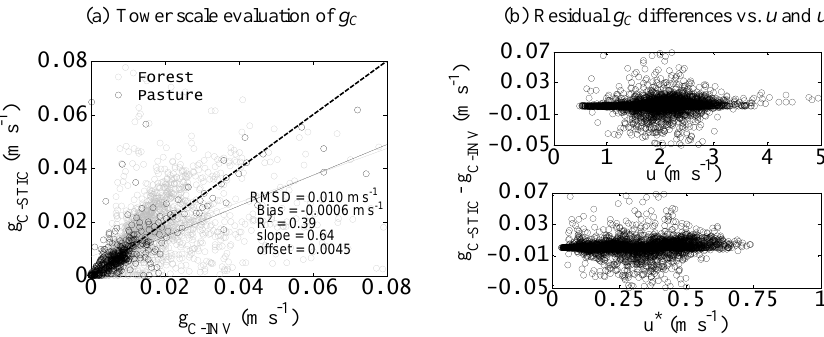
Figure 3. (a) Comparison between STIC-derived g C ( g C-STIC ) and g C computed by inverting the PM model ( g C-INV ) over the LBA EC sites, where g A-BM13 was used as aerodynamic input in conjunction with tower measurements of λE , radiation and meteorological variables, and (b) residual g C differences vs. wind speed ( u ) and friction velocity ( u ∗ ) over the LBA EC sites.